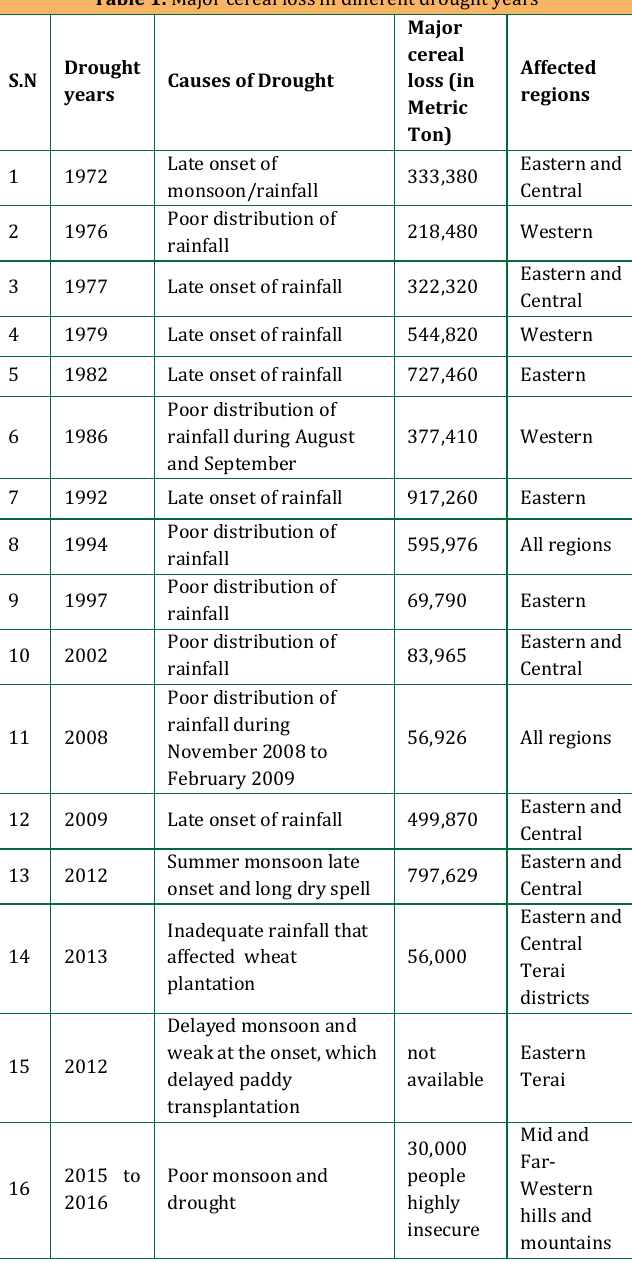
Table 1: Major cereal loss in different drought years